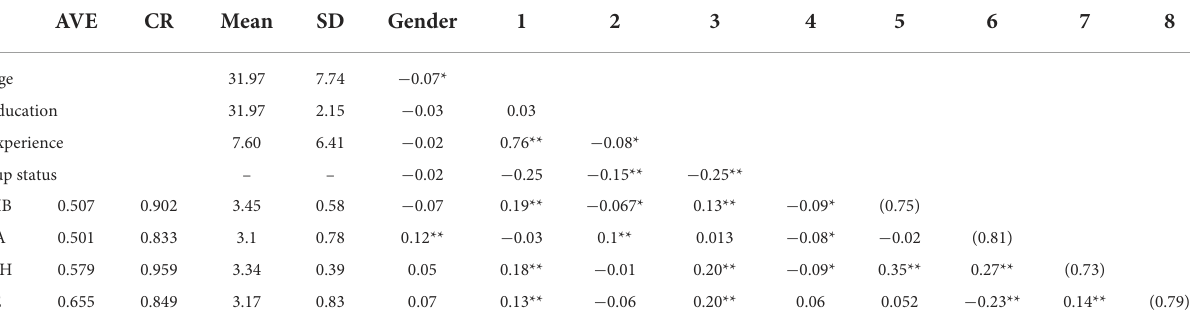
TABLE 2 Correlations and